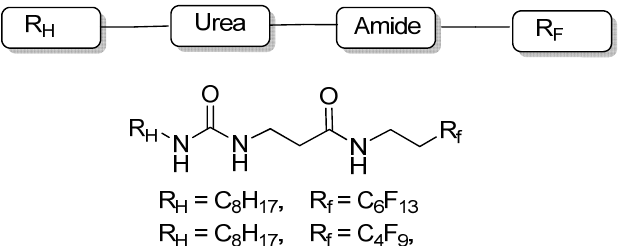
Figure 1. General structure and examples of partially fluorinated urea-amide gelators described in